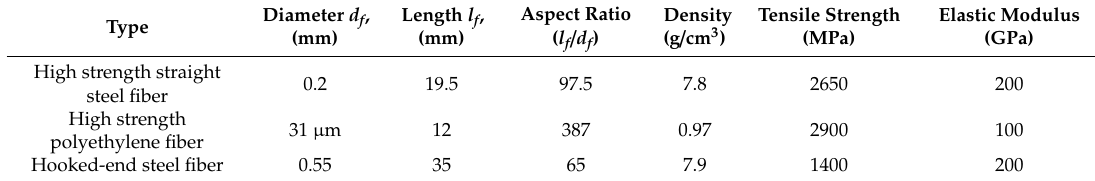
Table 4. Properties of fibers.